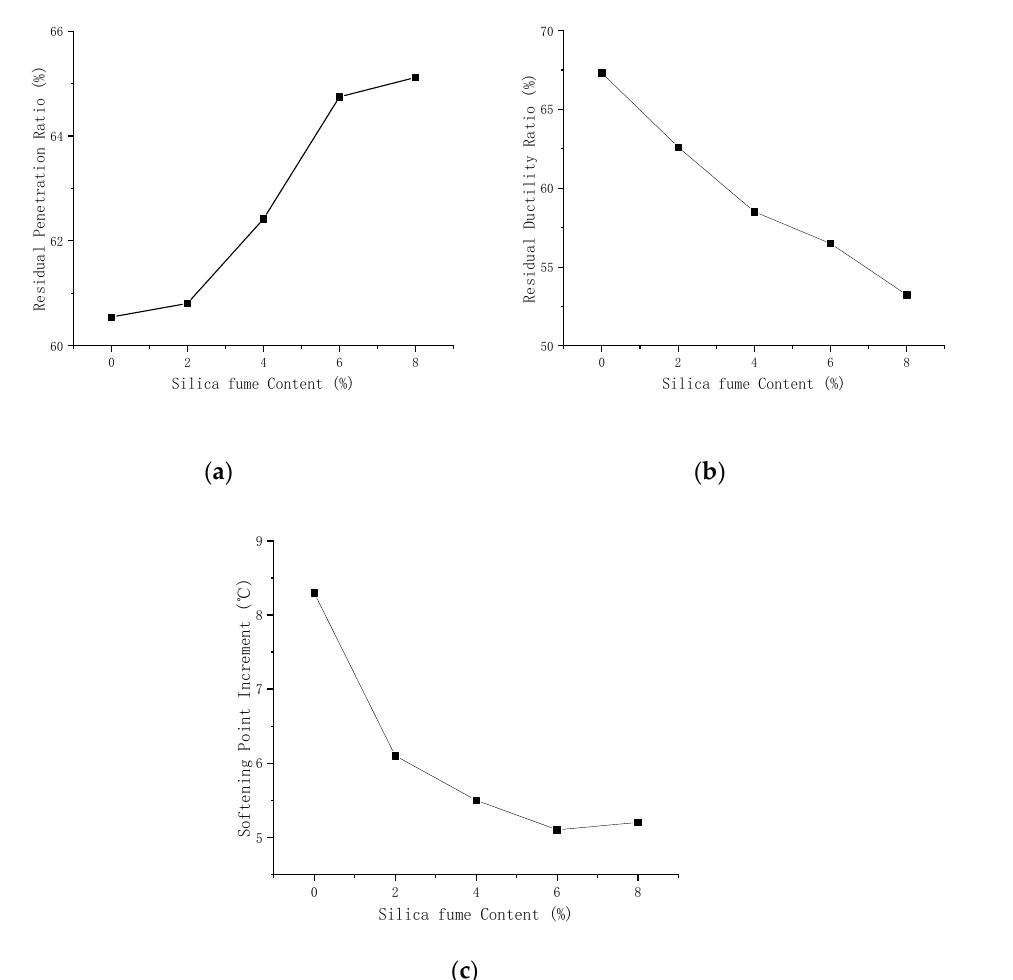
Figure 1. Plots of the temperature and the ( a ) residual penetration ratio, ( b ) residual ductility ratio, and ( c ) softening point increment.